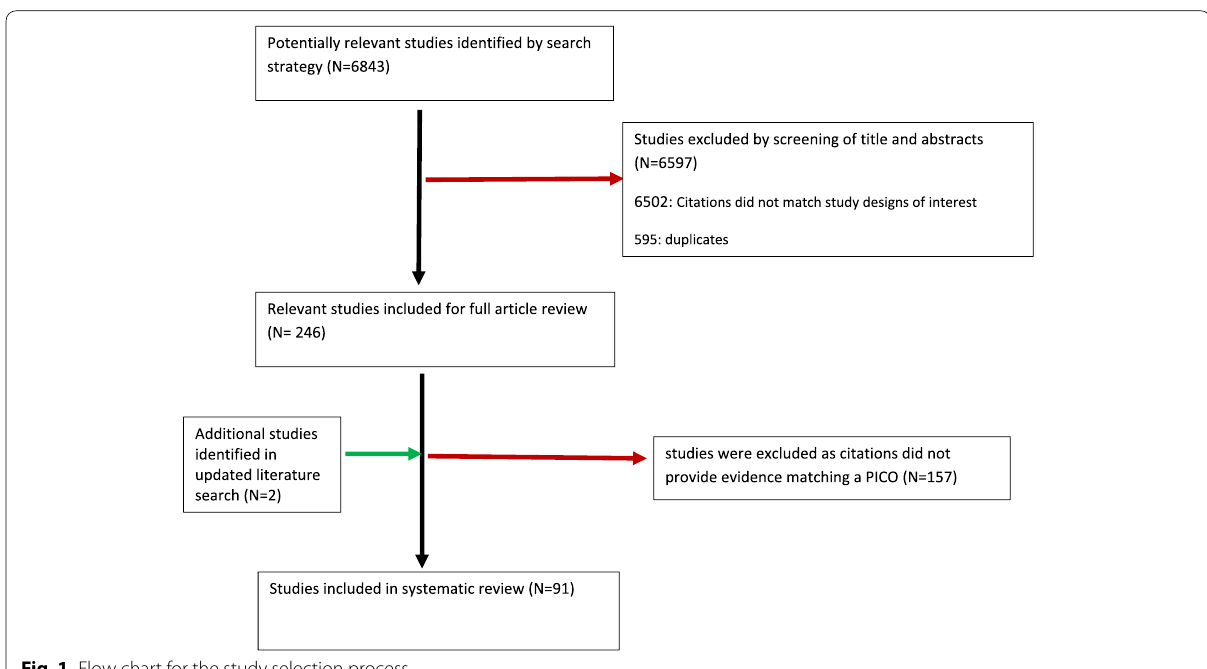
Fig. 1 Flow chart for the study selection